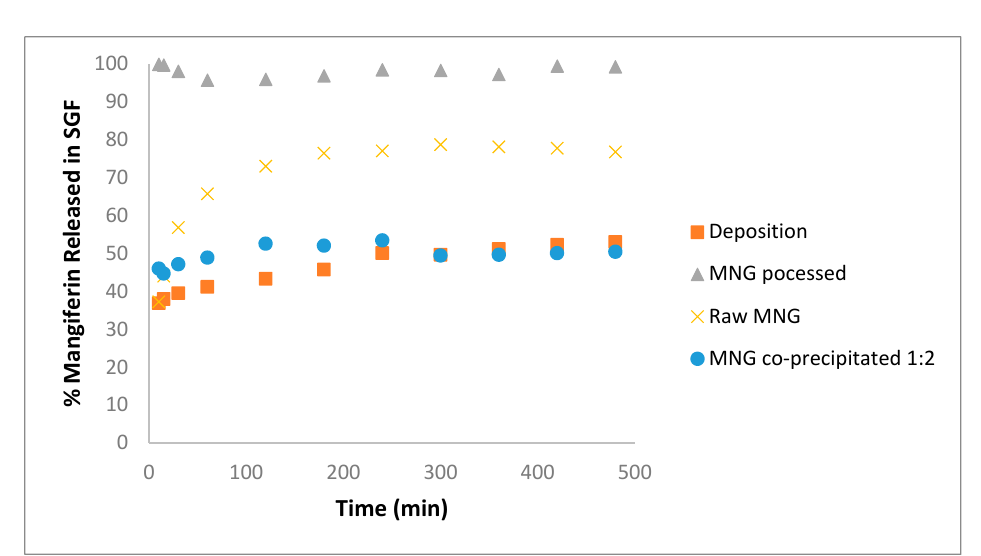
Figure 10. Release test of MNG from composites in SIF corresponding to experiment 6 (180 bar, 323 K, 30 g/min CO 2 flow rate, SAS1). 4. Conclusions Pressure and temperature conditions affect the success of the deposition process of the co- precipitates. The use of conditions well above the critical point of the mixture favors the deposition of the precipitates on silica. The low CO 2 /dissolution flow rate ratio leads to precipitates with solvent residues and in less appreciable quantities. The deposition of the co-precipitates on the silica occurs mainly at the bottom of the precipitator under conditions far above of the MCP, with the presence of silica in the rest of the precipitator very limited. Both the SAS1 and SAS2 configurations are appropriate to deposit co-precipitates onto silica particles, with a slight difference observed in the morphology of the co-precipitate in the case of the MNG. The release of co-precipitate deposited on silica presents higher dissolution rates in SGF than in SIF for both antioxidants. The presence of silica inside the vessel during the SAS process provides mixed co-precipitate and matrix without an adverse effect on the benefits in terms of improving the protection of the active substance during the release test in SFG when compared to co-precipitate releases in the absence of silica. This approach also facilitated total and burst dissolution in SIF—in contrast to co-precipitate releases without the presence of silica.